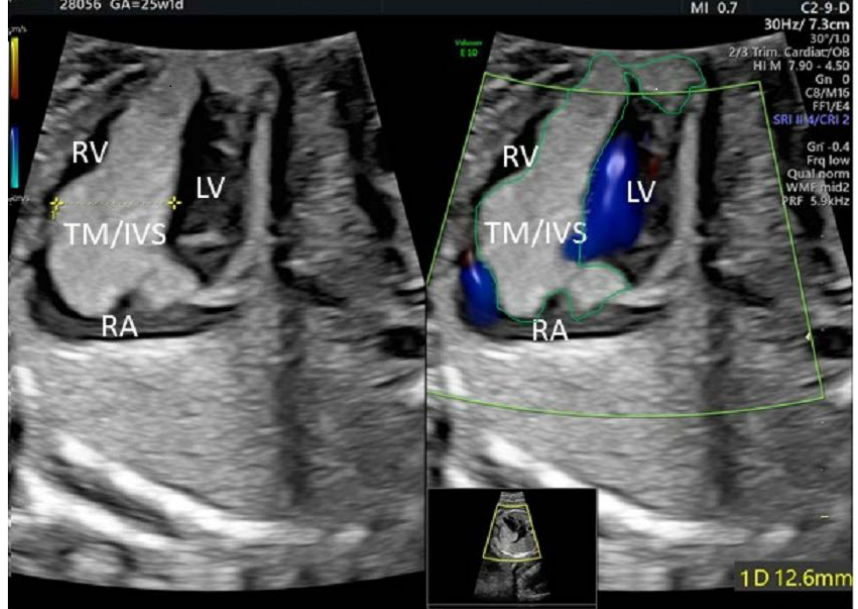
Figure 1. Echocardiographic four-chamber view at 25 + 1 GW showing a large rhabdomyoma covering nearly the entire right side of the cardiac structures. TM: tumor, IVS: interventricular septum; RA: right atrium; RV: right ventricle; LV: left ventricle (tumor circumference in green).